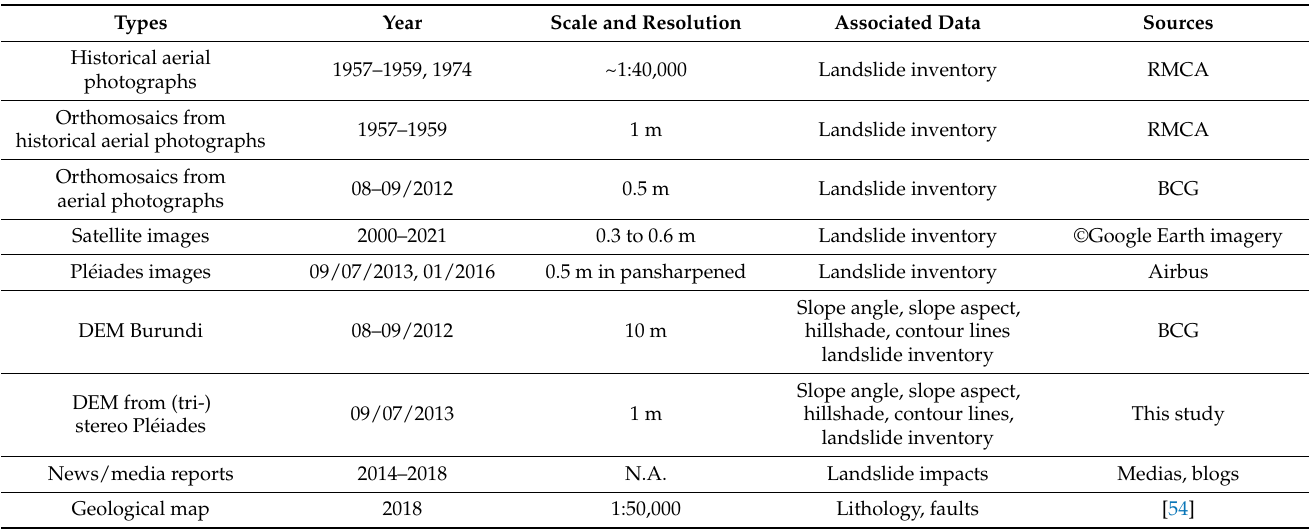
Table 1. Ancillary information used in this research. RMCA: Royal Museum for Central Africa; BCG: Bureau de Centralisa- tion G é omatique; DEM: Digital Elevation Model; N.A.: Not